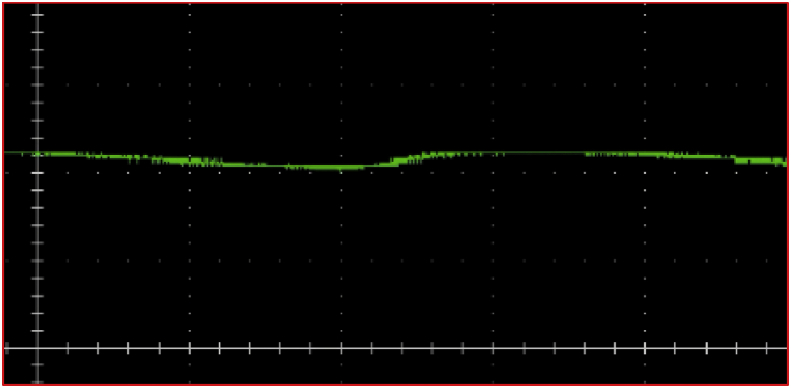
Dc-link voltage.